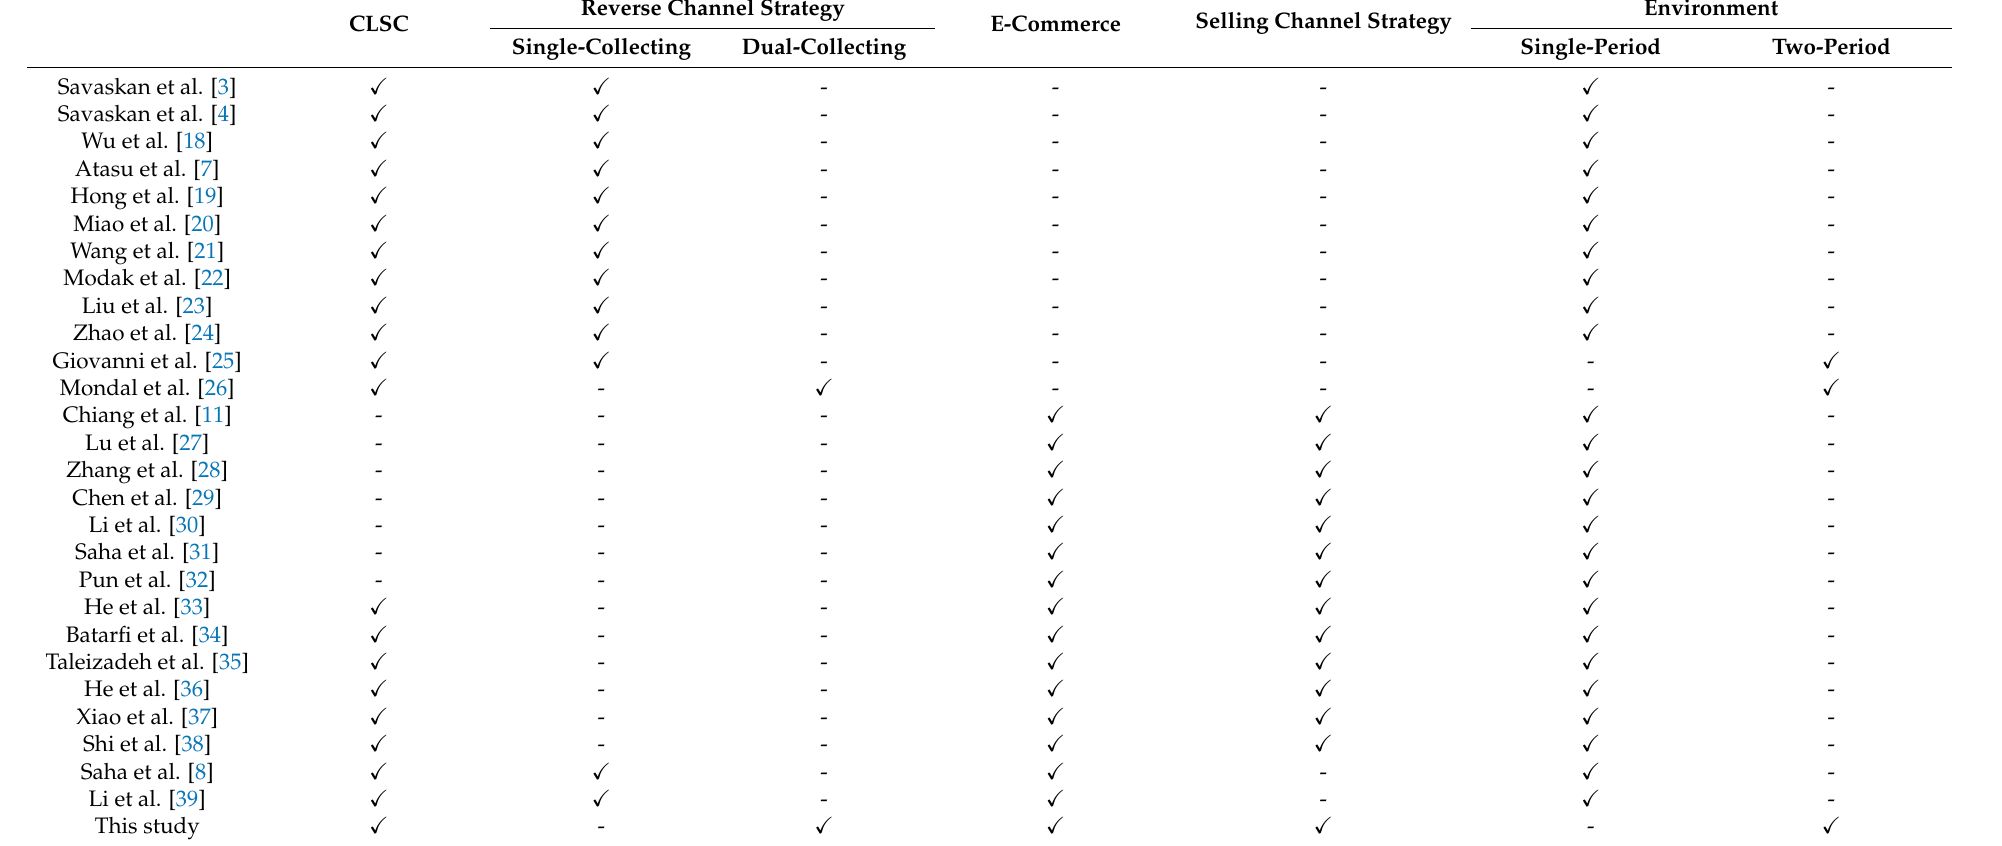
Table 1. Representative literatures positioning of this